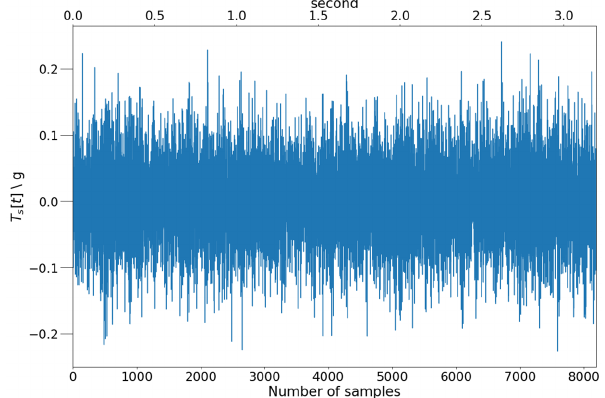
Figure 3. Time series data from a top axial sensor ( = 1 s